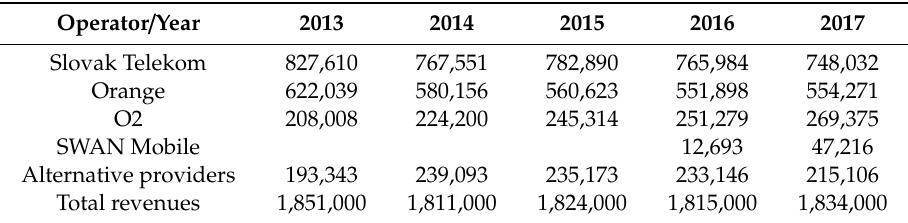
Table 1. Revenues of operators in the telecom sector (in € ).